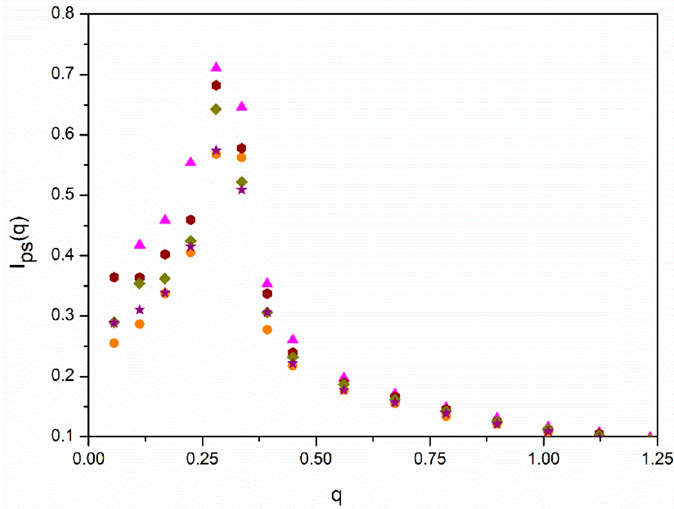
Figure 5. Scattering functions obtained with identical optical contrast factors for A and B units with respect to the solvent, Equation (9), see text, vs. the scattering variable, q , for the N = 145, f = 12, Φ ≅ 0.135 case and different values of the segregation parameter. Magenta triangles up, ε = 0; wine hexagons: ε = 0.15; dark yellow rhombuses: ε = 0.10; purple stars: ε = 0.15; orange circles: ε = 0.20.